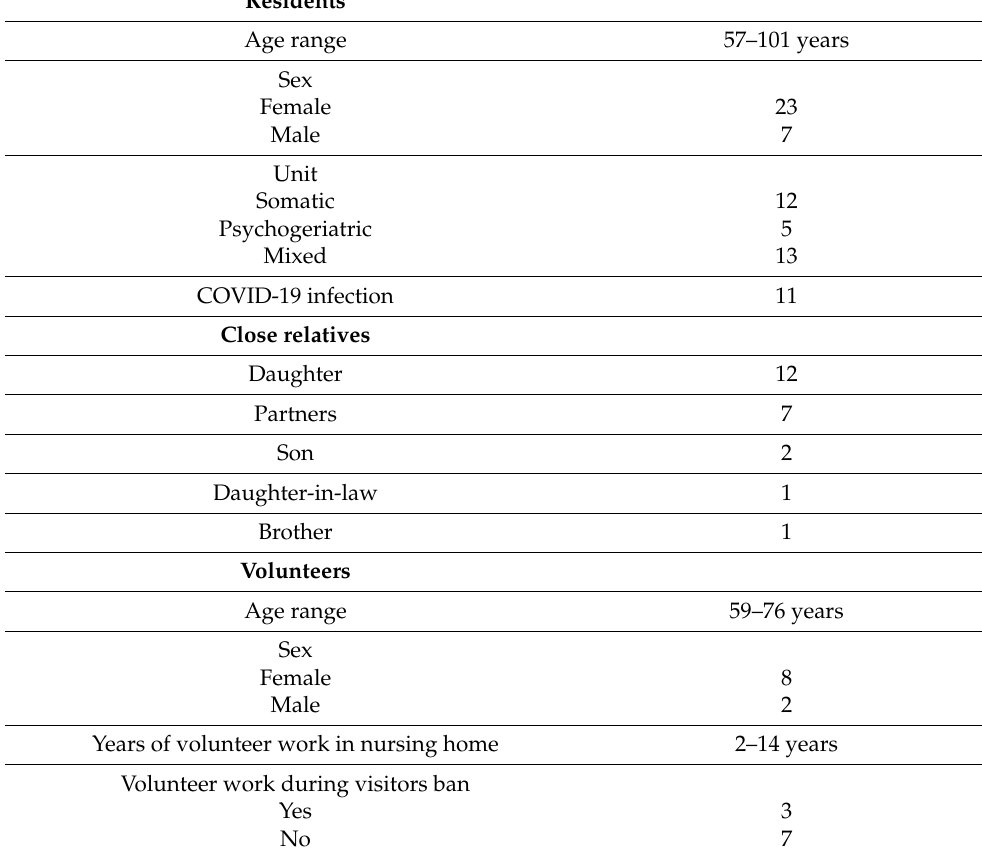
Table 1. Participants’